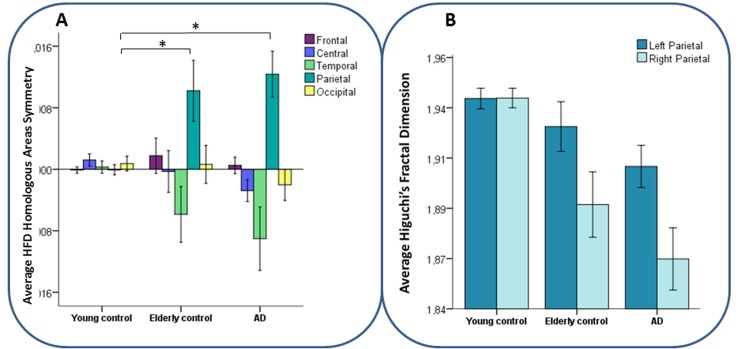
A) Average HFD HArS values of brain regions per group. Deviance from null-line indicates asymmetric HFD in homologous areas. Significant (p < .01) group difference in parietal HFD HArS are indicated by a star (*). B) Average HFD values of left and right parietal regions per group. Parietal asymmetry in elderly controls and AD patients is caused by a stronger HFD decline in the right compared to the left hemisphere. Error bars display the 95% confidence interval of the means.